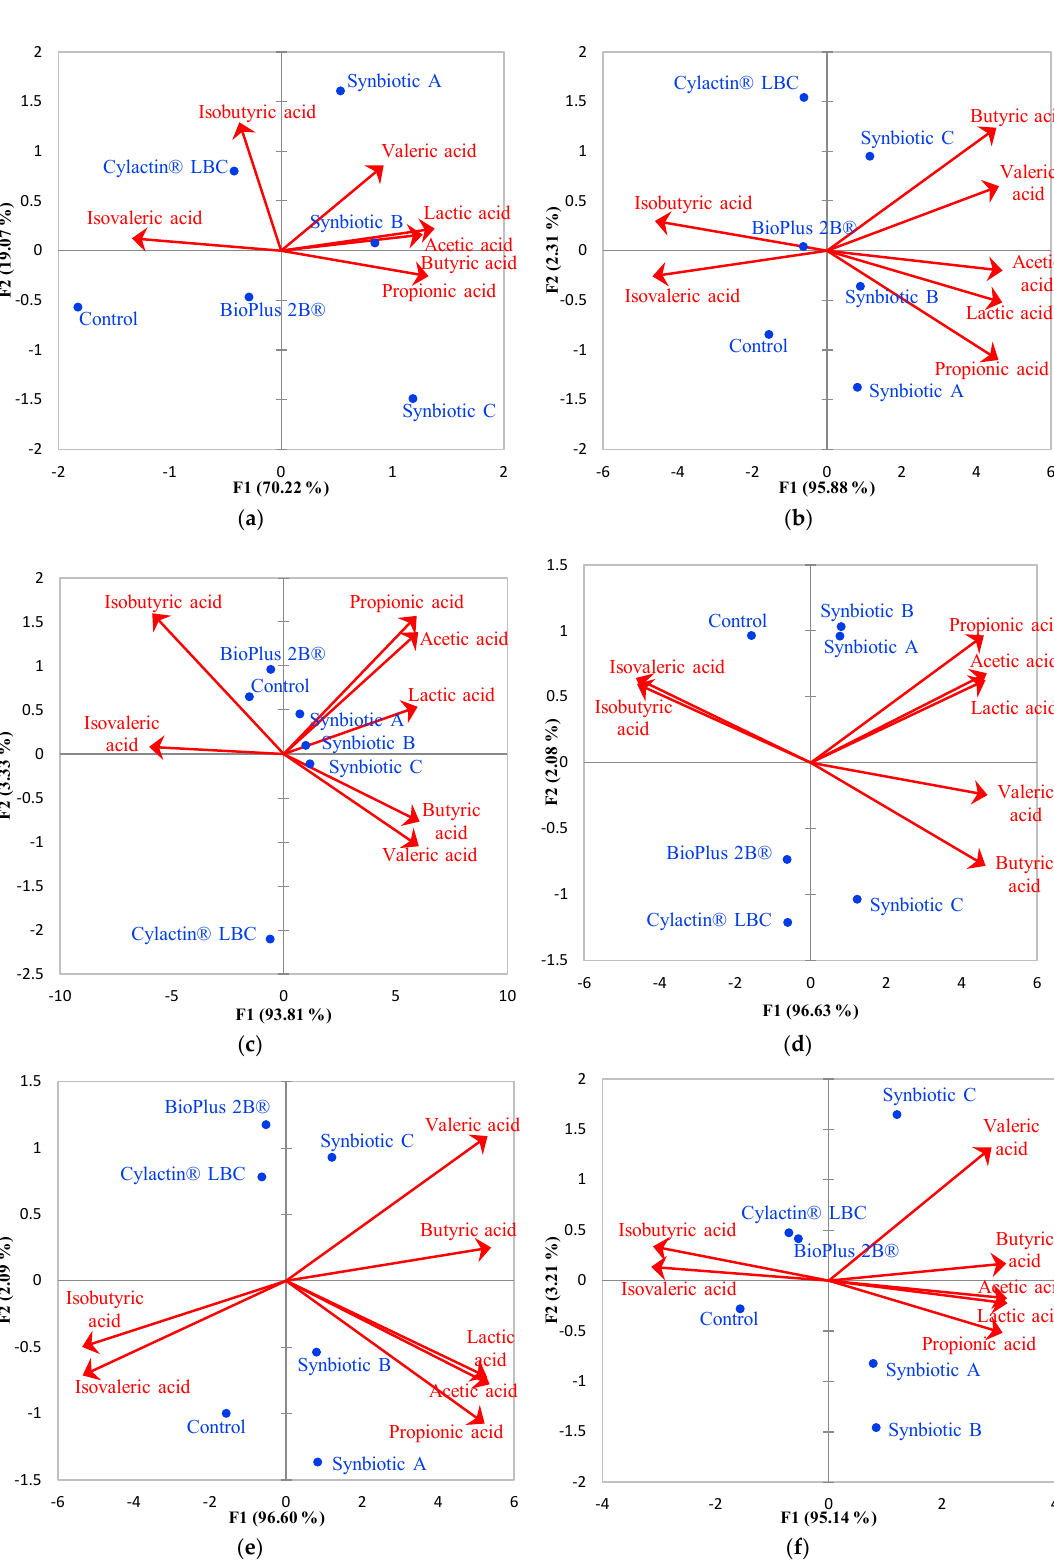
Figure 4. Heatmap presents changes in lactic acid, SCFAs, and BCFAs concentrations in piglets’ feces in correlation with the administrated feed additives. Columns correspond to the preparations used to modify piglets feed (directly or indirectly), whereas rows are assigned to analyzed organic acid and the day of piglets’ life when fecal samples were collected, namely, 7th and 28th (suckling piglets), 35th and 68th (weaned piglets), and 73rd and 165th (finisher pigs).